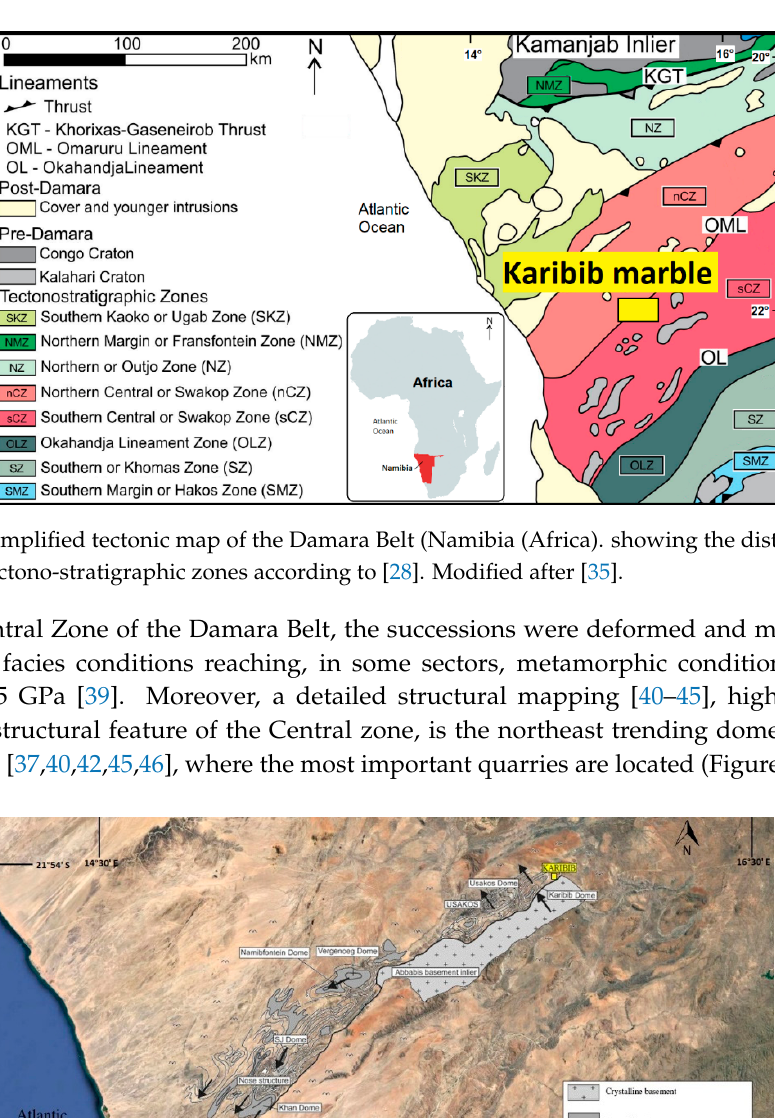
Orogen (Figure 1) is constituted by three orogenic belts: The intracontinental Damara belt and the coastal belt, the Kaoko belt, and the Gariep belts [35–38].